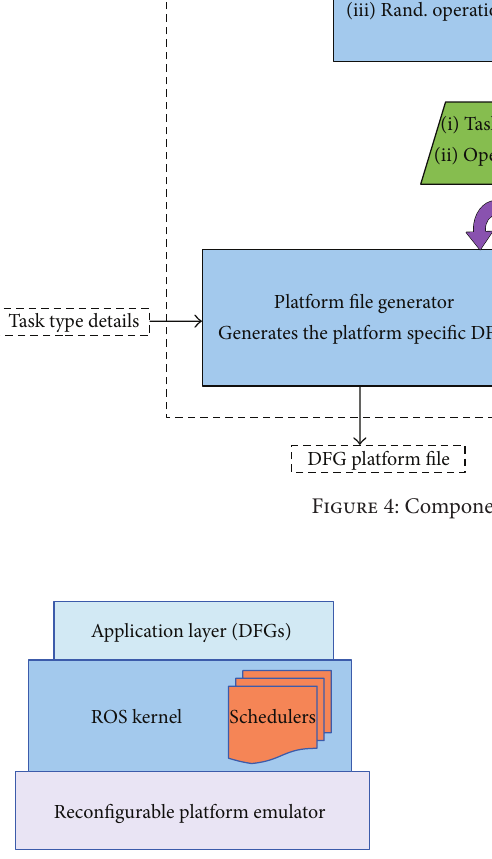
Figure 5: Reconfigurable simulator